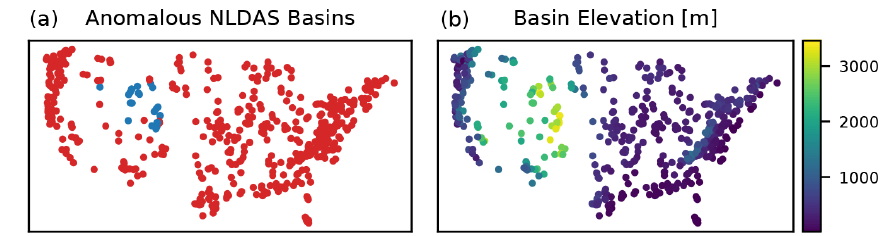
Figure C3. Spatial distribution of anomalous NLDAS basins shown in Fig. C2 (a) compared with elevation of the CAMELS basins (b) .